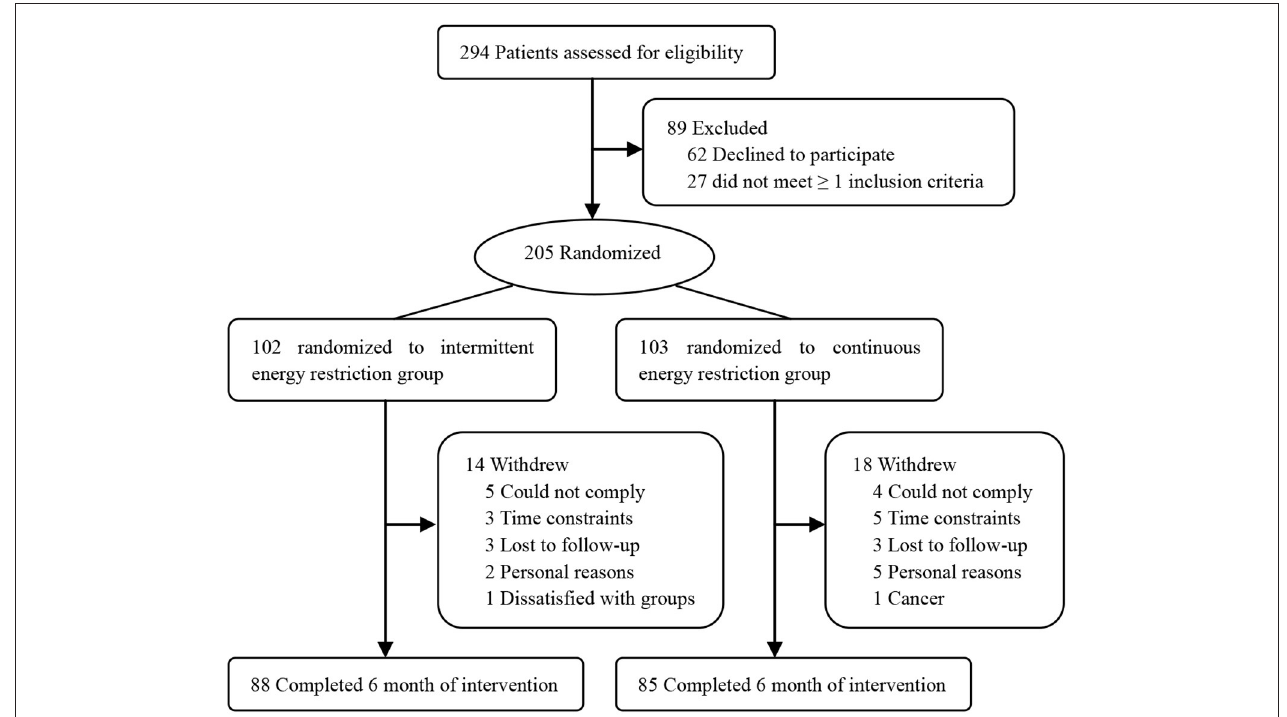
FIGURE 1 | Participant flow